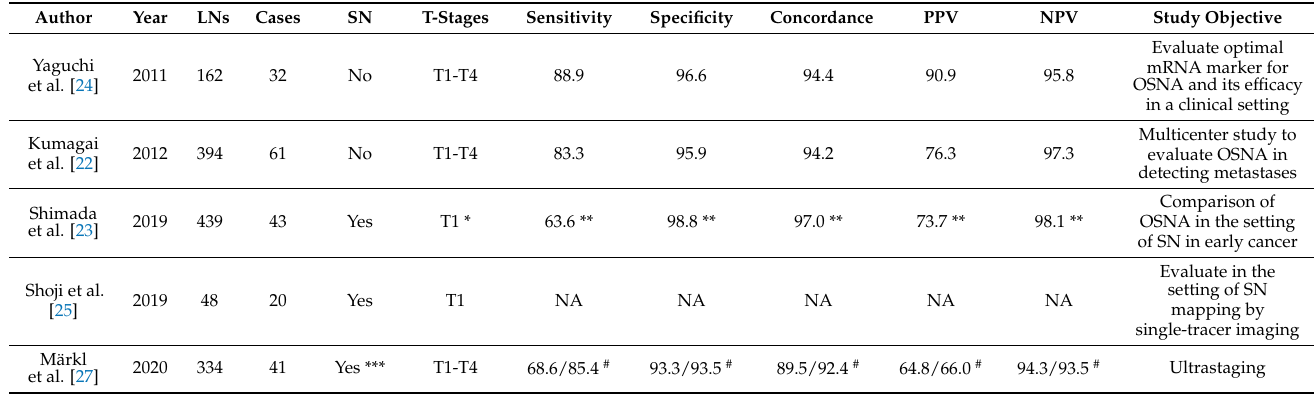
Table 2. Diagnostic value parameters of